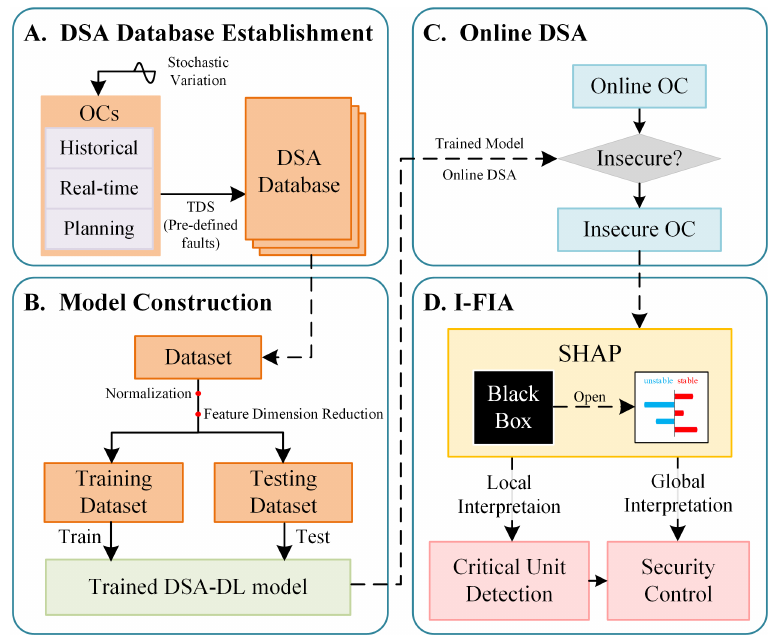
Figure 1. Overall flowchart of I-FIA for DSA-DL